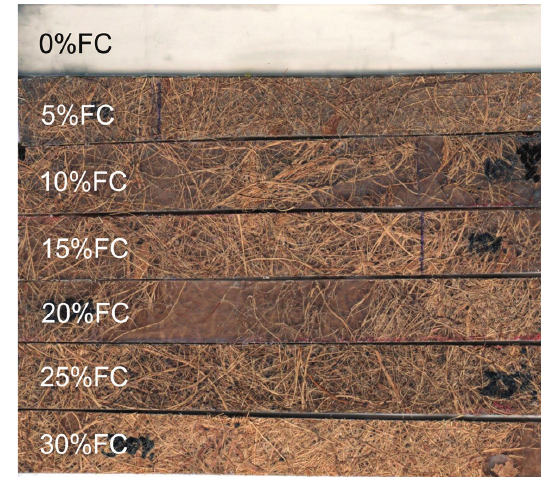
Figure 4. Coconut fibers-PP composites aspect used in dynamic